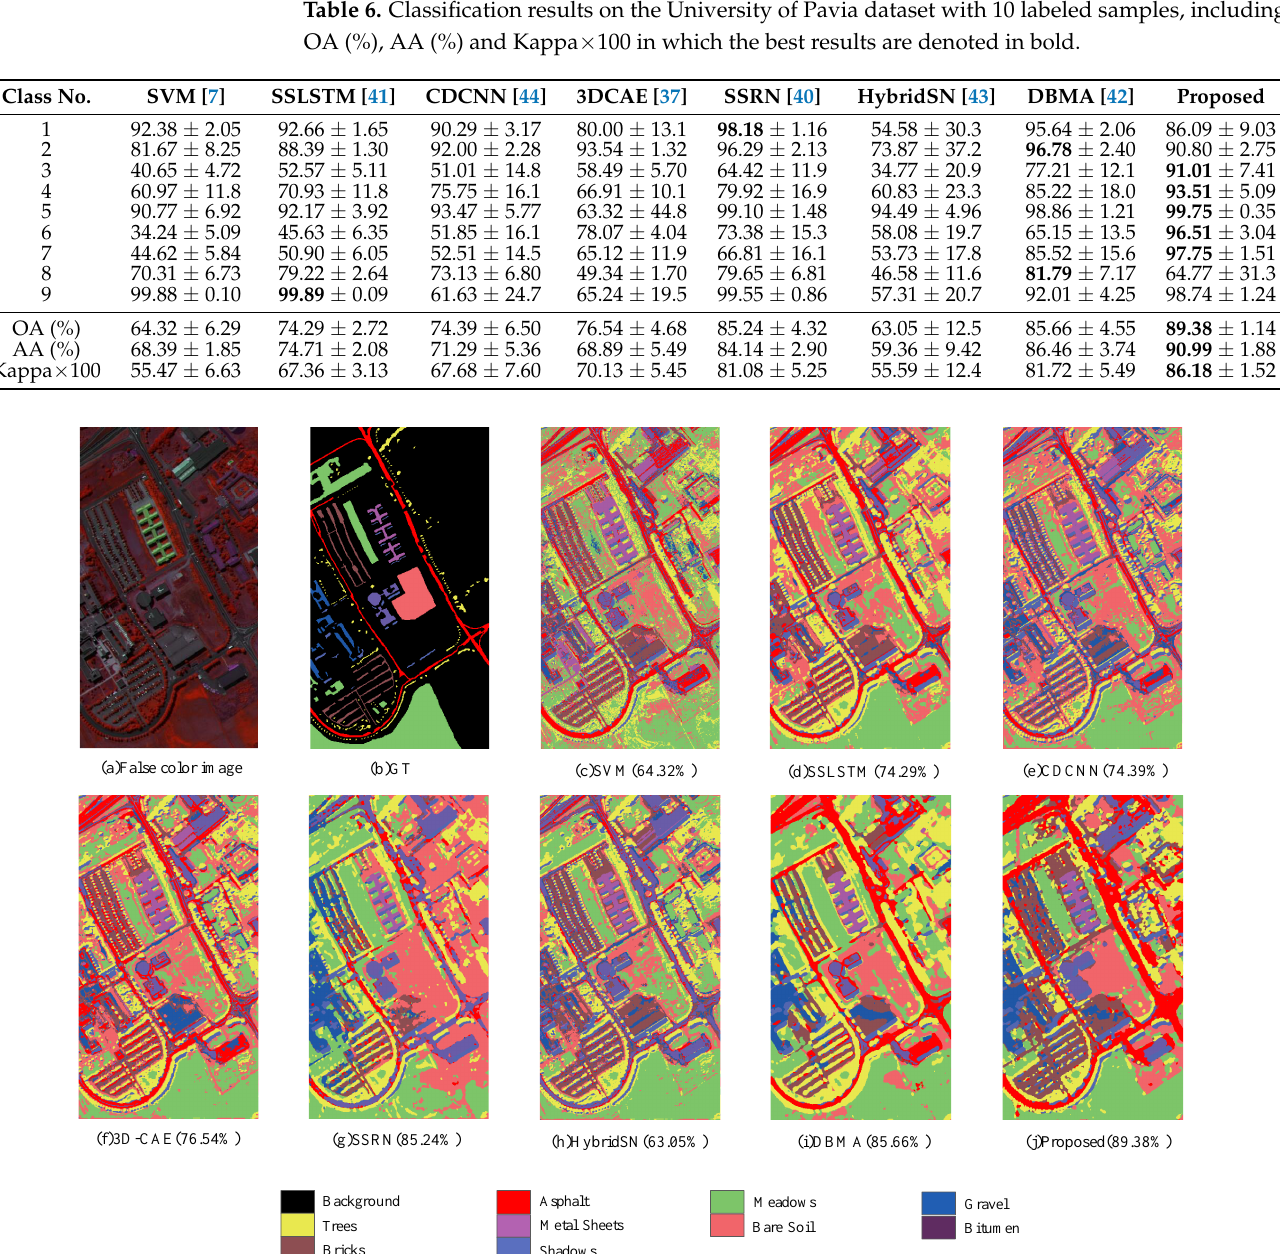
Figure 5. The classification maps of the University of Pavia with 10 labeled